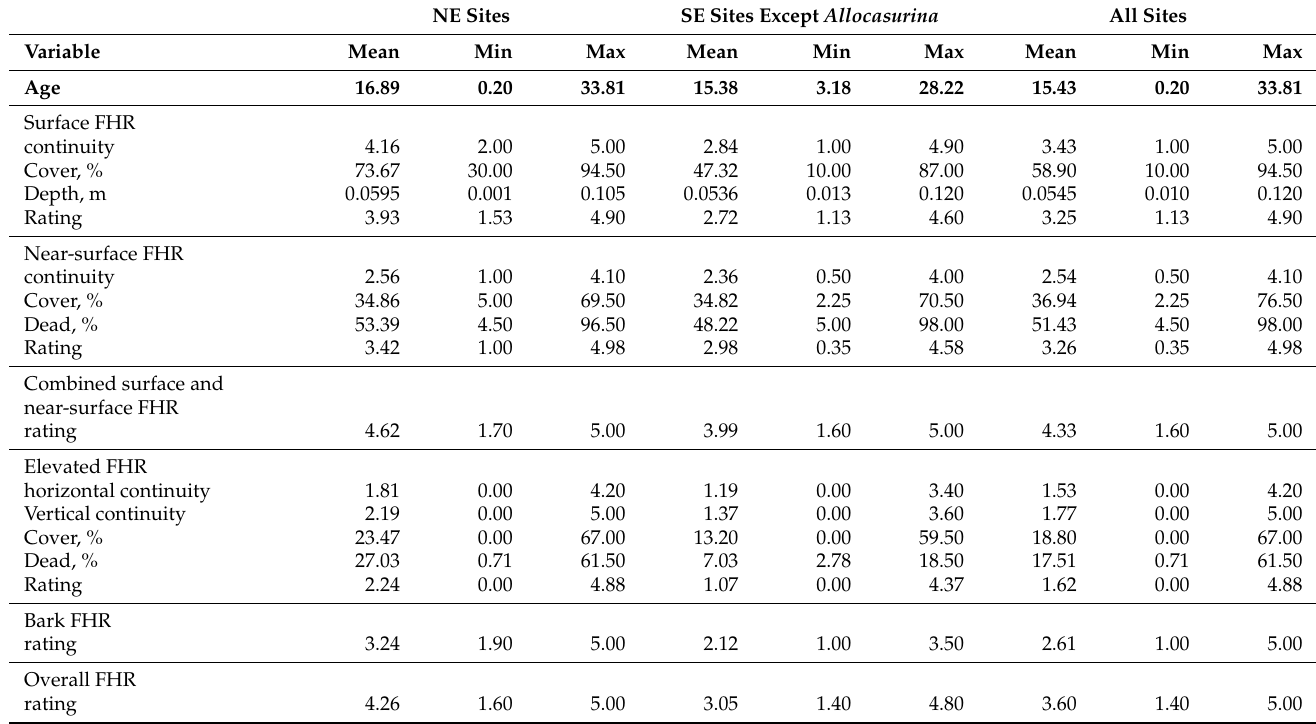
Table 2. Fuel hazard rating data